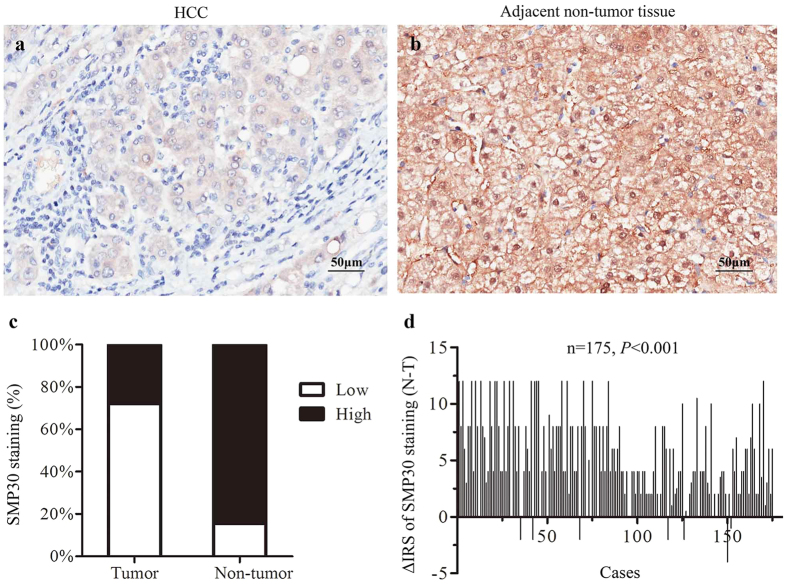
Showing the expressions of SMP30 protein in tumor and in paired adjacent non-tumor tissues.(a,b) Immunohistochemical representative images of SMP30 expression in matched tumors and in adjacent non-tumor tissues. (c) SMP30 expression staining is lower in HCC tissues than those in paired adjacent non-tumor tissues. Immunohistochemical staining data were from 175 pairs of tissues. (d) The distribution of the difference in SMP30 staining (ΔIRS = IRSN-IRST). IRS was from 175 pairs of tissues (Note: T: tumor tissues; N: non-tumor tissues). The P values were obtained by the Wilcoxon method.